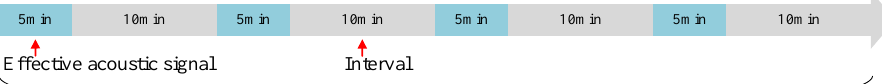
Figure 11. The distribution of data collection time in a day.